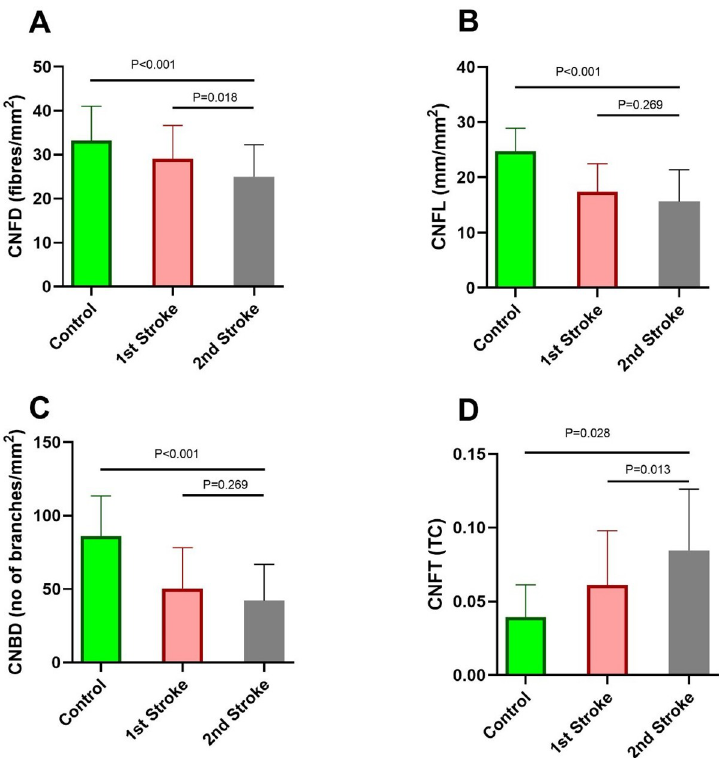
Fig 1. Corneal nerve fiber parameters in patients with 1 st ischemic stroke, recurrent (2 nd ) ischemic stroke and control subjects. (A) CNFD: Corneal nerve fiber density; (B) CNFL: Corneal nerve fiber length; (C) CNBD: Corneal nerve branch density; (D) CNFT: Corneal nerve fiber tortuosity. Data are expressed as mean ±